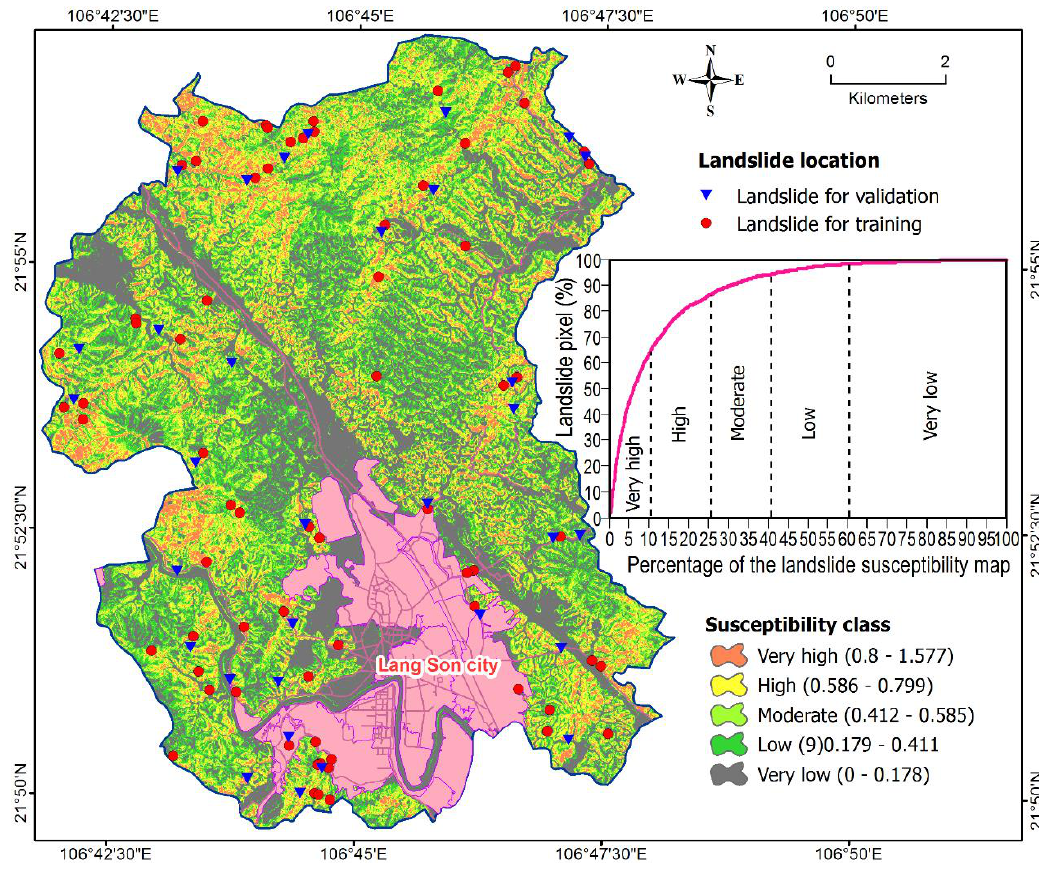
Figure 10. Landslide susceptibility map using the RVM model optimized by the ICA algorithm for the study area.